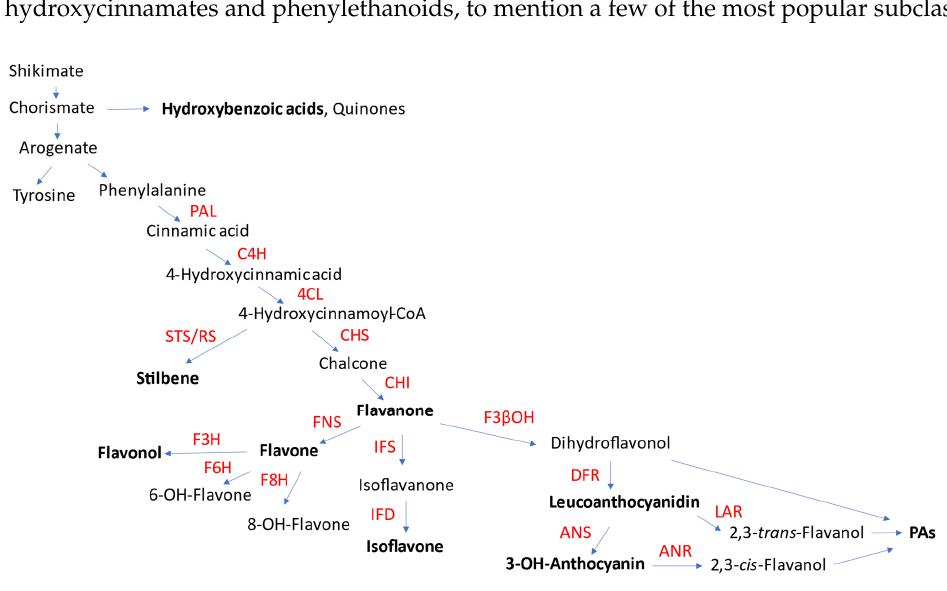
Figure 1. Simplified scheme of biosynthesis of selected plant polyphenols and positions of biosyn- thetic enzymes mentioned in the review (PAL—phenylalanine ammonia lyase; C4H—cinnamate 4-